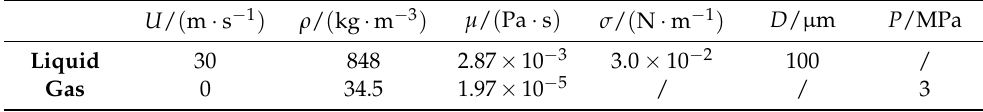
Table 1. Gas and liquid flow